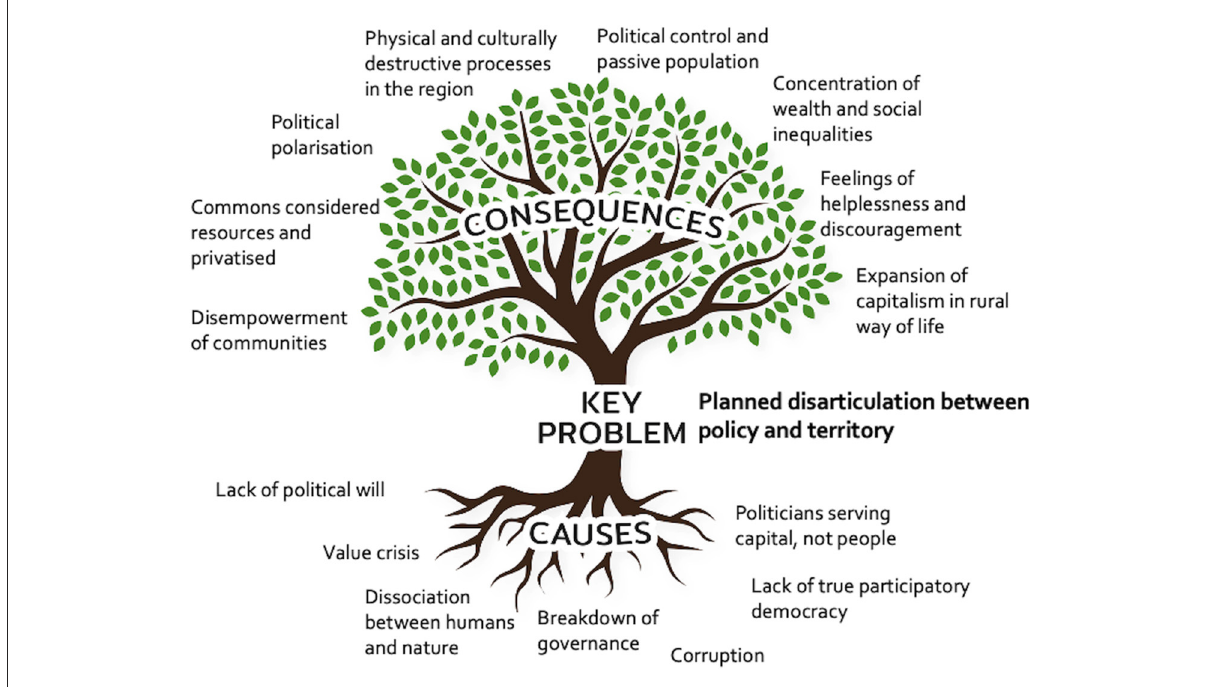
FIGURE6 Problem tree 3—Planned disarticulation between policy and territory.